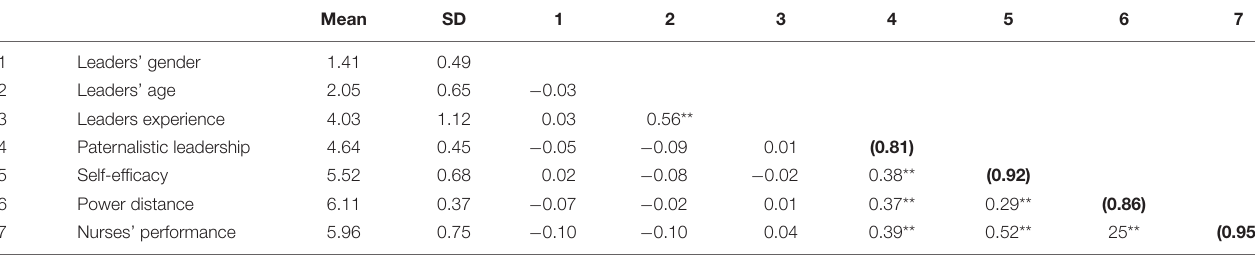
TABLE 1 | Mean, standard deviation, correlation.